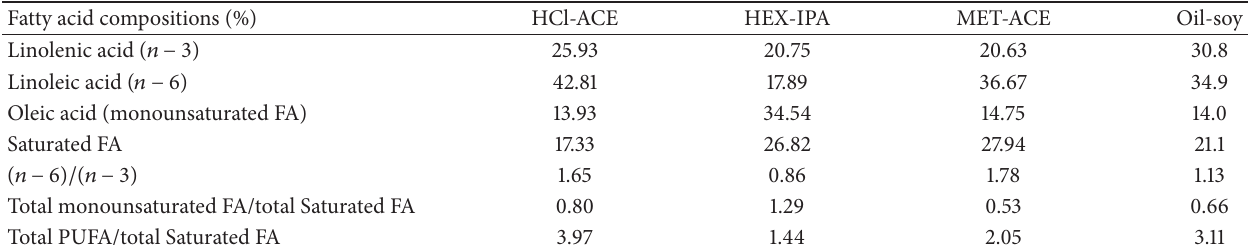
Table 3: 1 H-NMR spectroscopy results for FA compositions profiles ∗